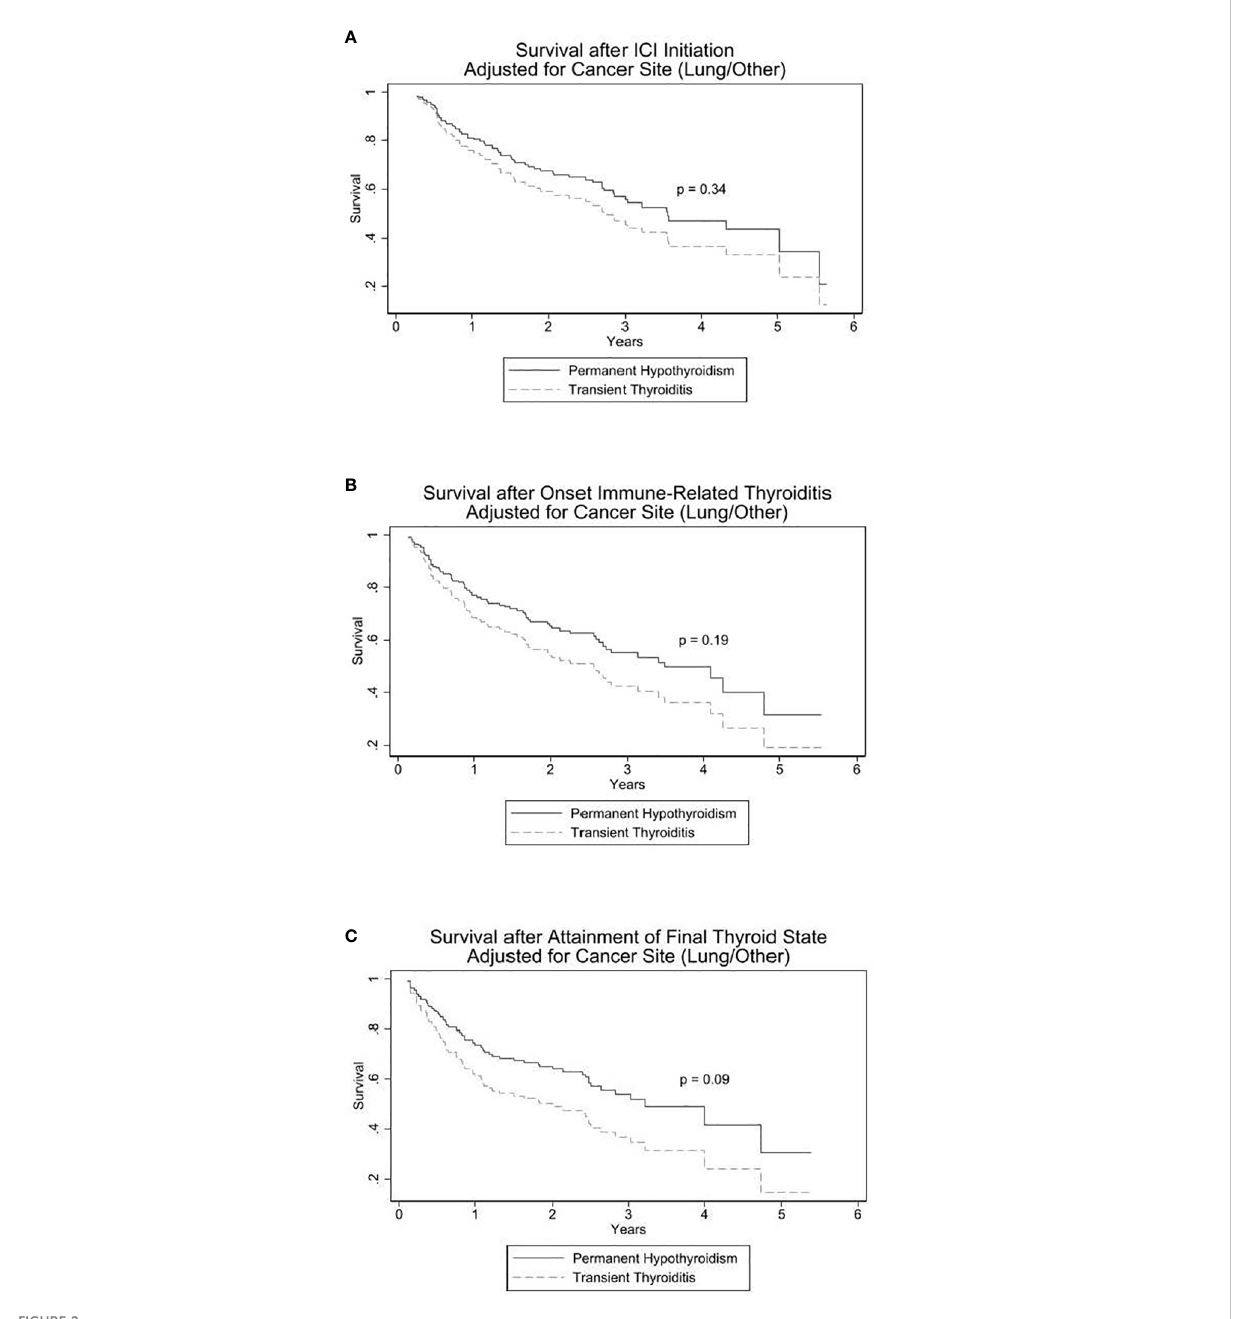
FIGURE 2 Cox proportional hazards models for survival in PH vs TT. In (A) , origin (start of observation) time is date of immune checkpoint inhibitor (ICI) initiation. In (B) , origin time is onset of thyroid irAE. In (C) , origin time is date at which the DT differentiated into PH (permanent hypothyroidism) or TT (transient